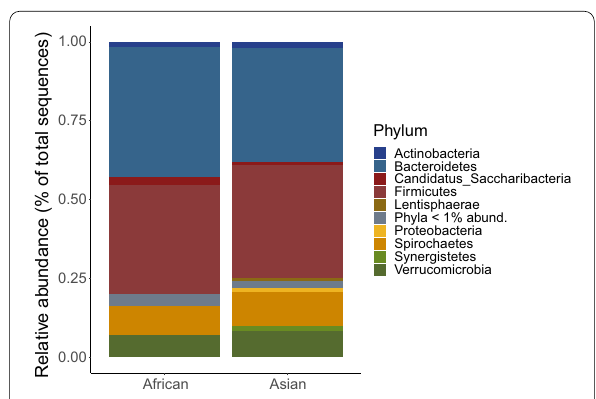
Fig. 1 Stacked bar plot depicting relative abundance of dominant bacteria phyla in African (n 69) and Asian (n 48) elephants. Phyla = = with an average relative abundance < 1% grouped together